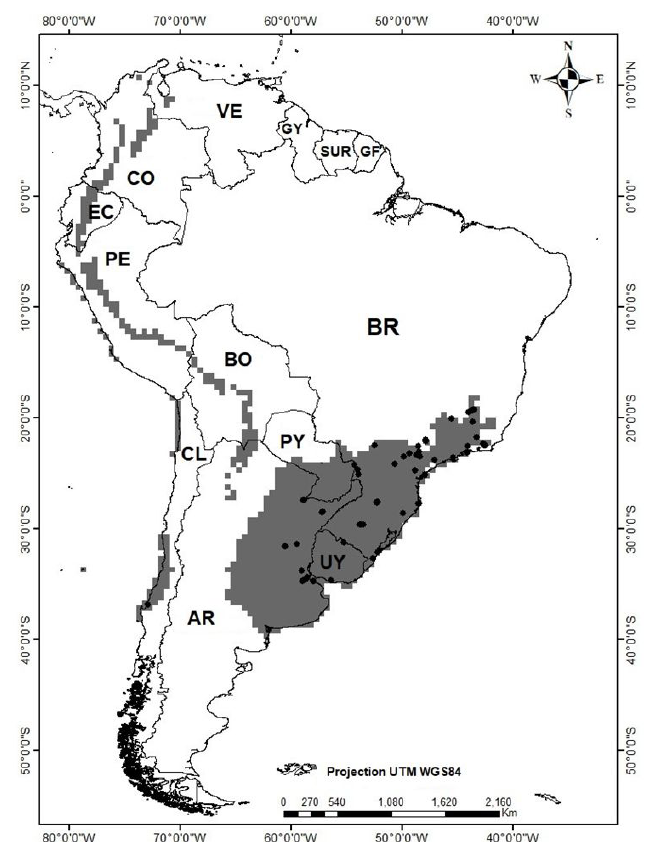
Figure 1. Map of the regions with subtropical climate in South America, based on the Köppen-Trewartha climate classification. Gray area = subtropical regions. Points: origin of the publications. AR: Argentina; UY: Uruguay; BR: Brazil; PY: Paraguay; CL: Chile; BO: Bolivia; PE: Peru; CO: Colombia; VE: Venezuela; EC: Ecuador; GY: Guyana; SUR: Suriname; GF: French Guiana.